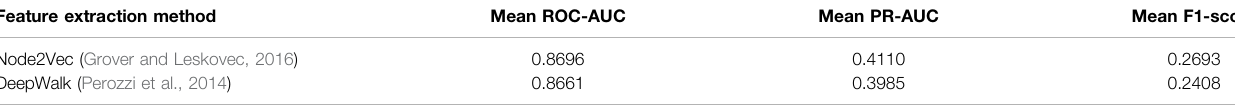
TABLE 3 | The average ROC-AUC, PR-AUC, and F1-score of the proposed model using different feature extraction methods. Feature extraction method Mean ROC-AUC Node2Vec (Grover and Leskovec, 2016)